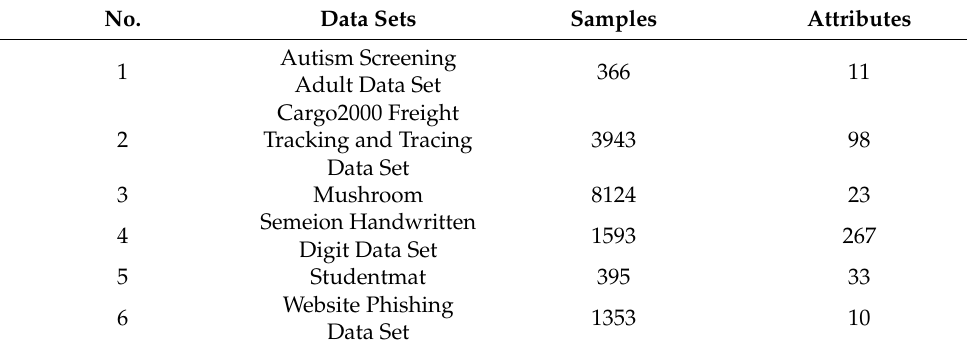
Table 3. Details of data